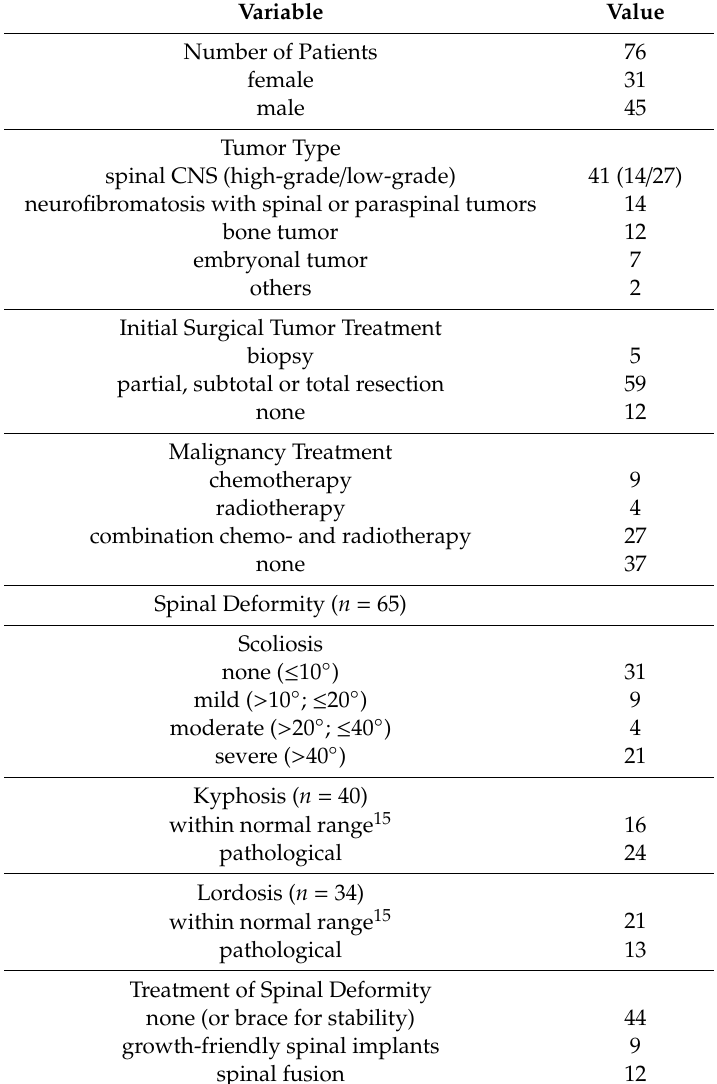
Table 1. Overview of patient